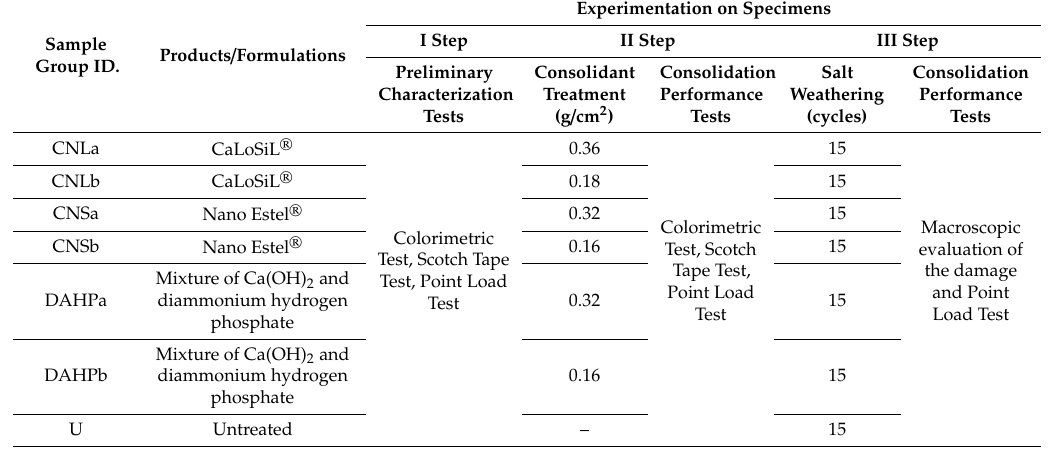
Table 2. List of specimens that underwent the three different phases of experimentation and details about products and methods used.